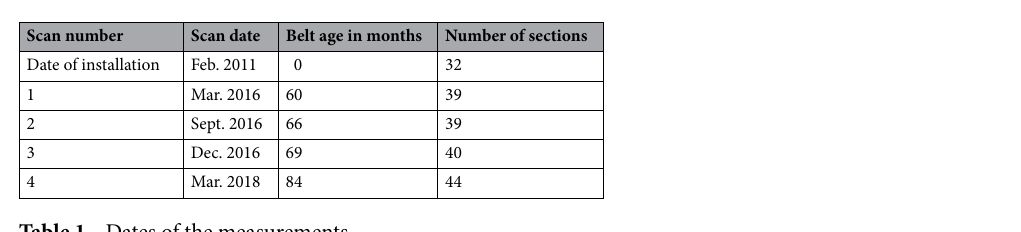
Table 1. Dates of the